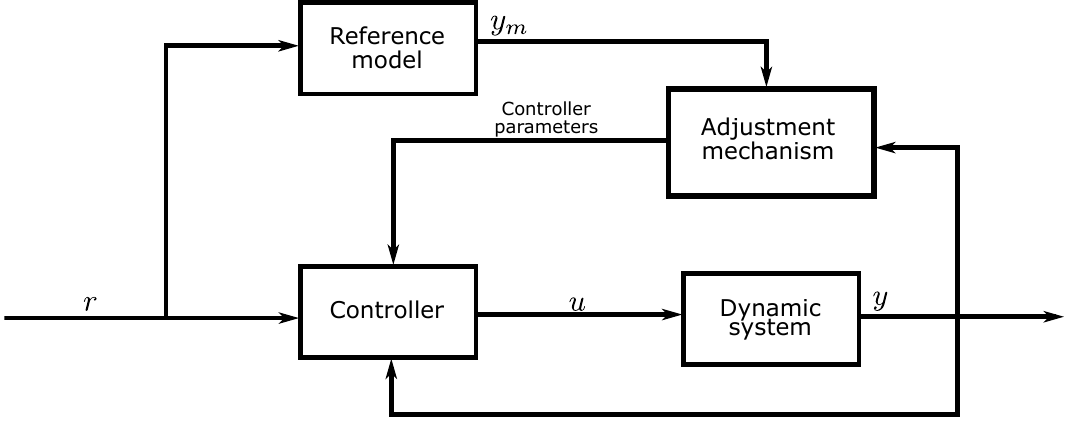
Figure 5. Model reference adaptive control (MRAC)